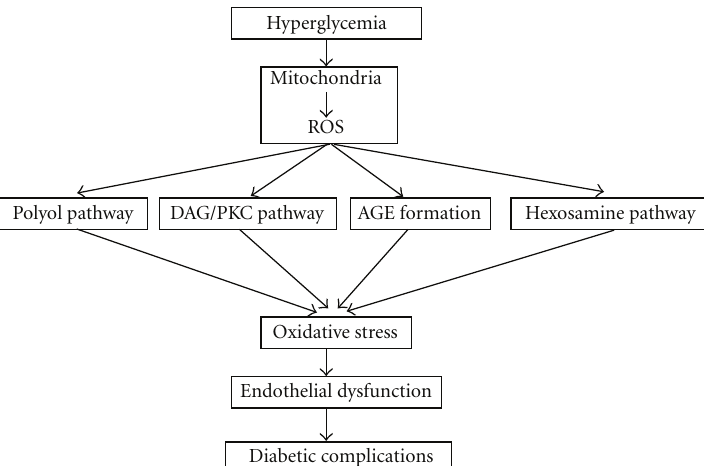
Figure 3: Mechanisms of hyperglycemia which are supposed to cause endothelial dysfunction and in the end diabetic complications.